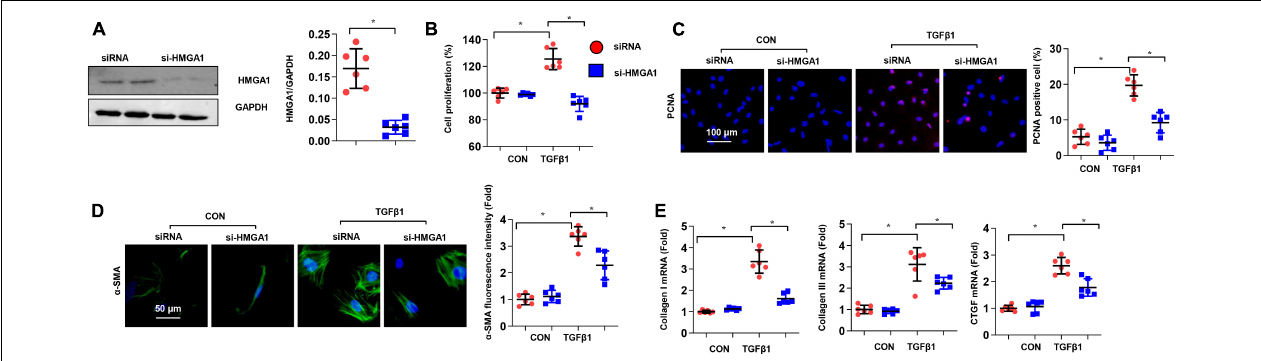
FIGURE 4 | High-mobility group A1 (HMGA1) deficiency reduced cardiac fibroblast proliferation and activation in vitro . (A) The protein level of HMGA1 in fibroblasts transfected with HMGA1 siRNA ( n = 6). (B–D) CFs were transfected with HMGA1 siRNA and stimulated with TGF β 1 for 24 h. (B) Cell proliferation detected by CCK8 assay ( n = 6). (C) Immunofluorescence staining of PCNA ( n = 5). (D) Immunofluorescence staining of α -SMA ( n = 5). (E) Transcription levels of collagen I, collagen III, and CTGF ( n = 6). * p <